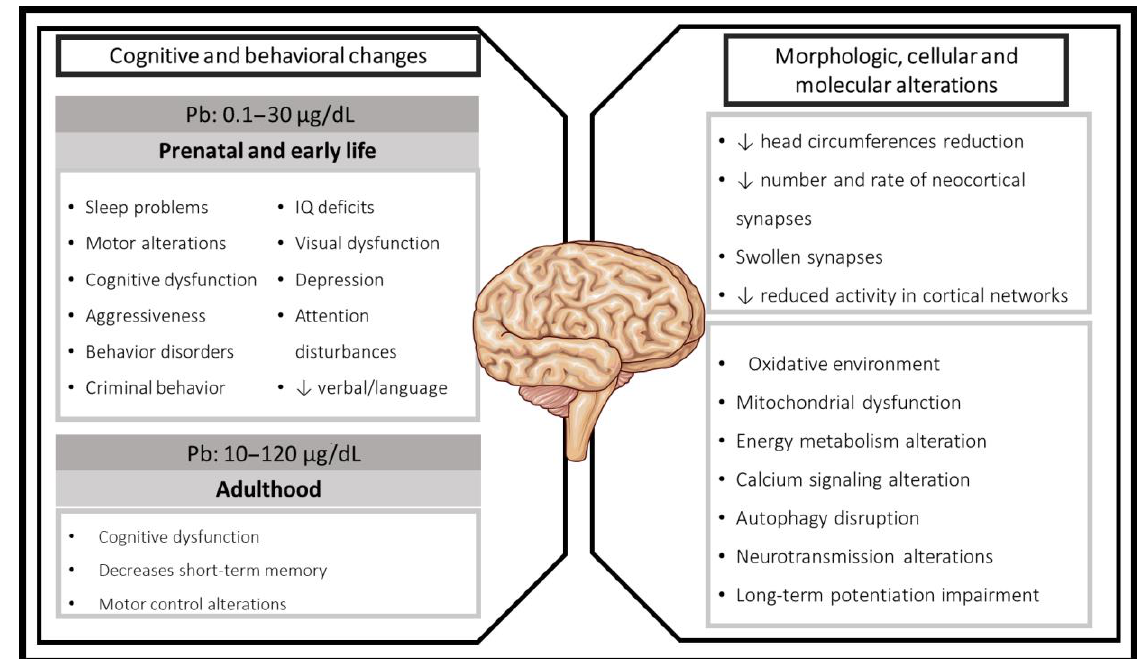
Figure 1. Cognitive and behavioral changes induced by Pb exposure in humans and associated morphologic, cellular, and molecular alterations of Pb toxicity.